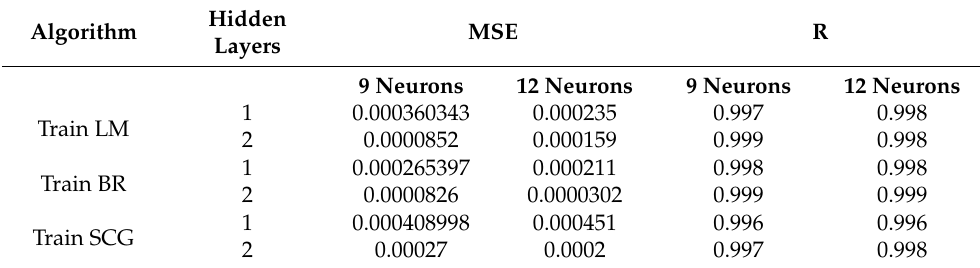
Figure 5. Accuracy test in terms of MSE of one hidden layer and two hidden layers MLA. Table 4. The performance of various MLA with different